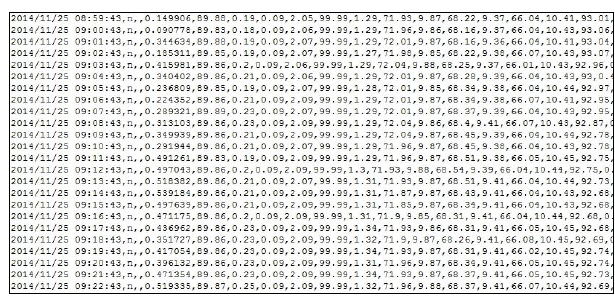
Fig. 6. DAS FTP stored data